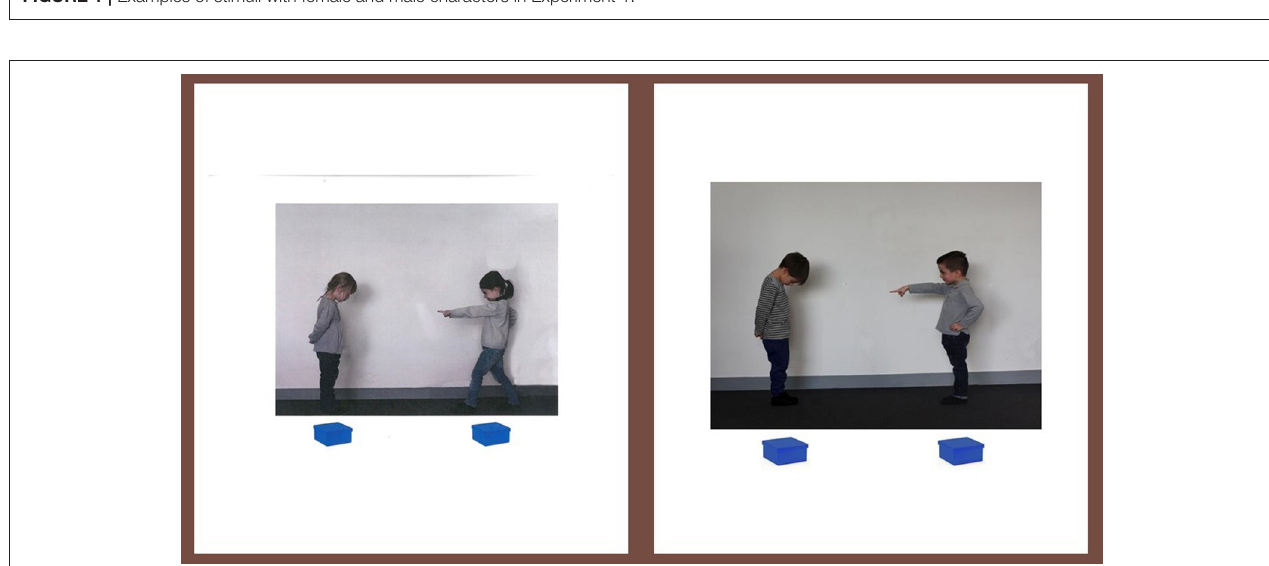
FIGURE 2 | Examples stimuli with female and male characters of Experiments 2 and 3’s. difference between age groups [ X 2 (1, 61) = 0.9, p = 0.3].